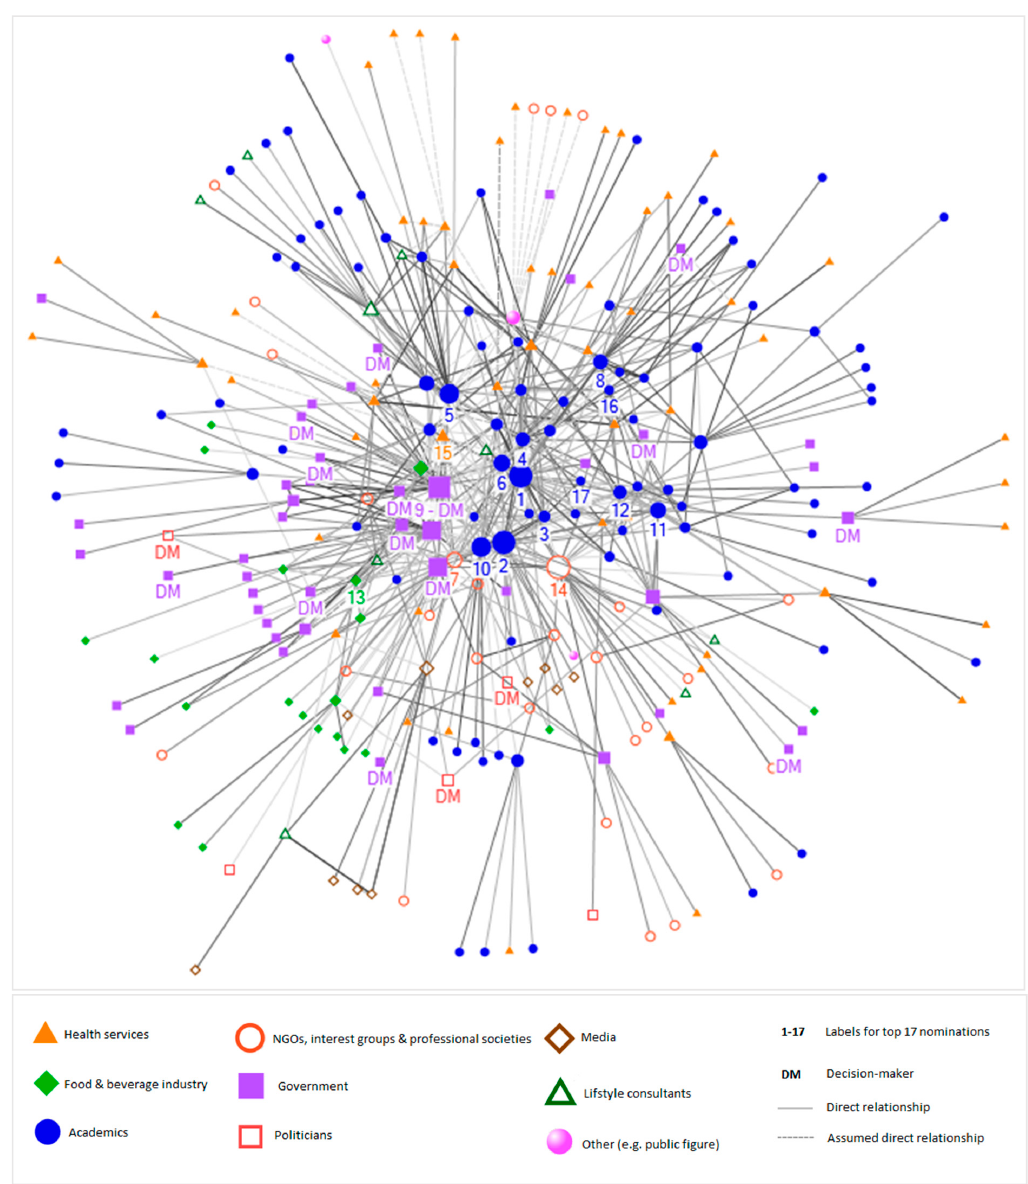
Figure 4. Network graph of overall diabetes and obesity network in New Zealand. The shape and colour of the nodes in the network indicate the professional category of an individual. The size of the nodes represents the betweenness centrality of an individual, with bigger nodes indicating a higher level of betweenness centrality. The grey-scale of the ties between individuals indicates the frequency of communication (ranging from light grey for annual contact to black for daily contact), and dotted lines are assumed direct ties.